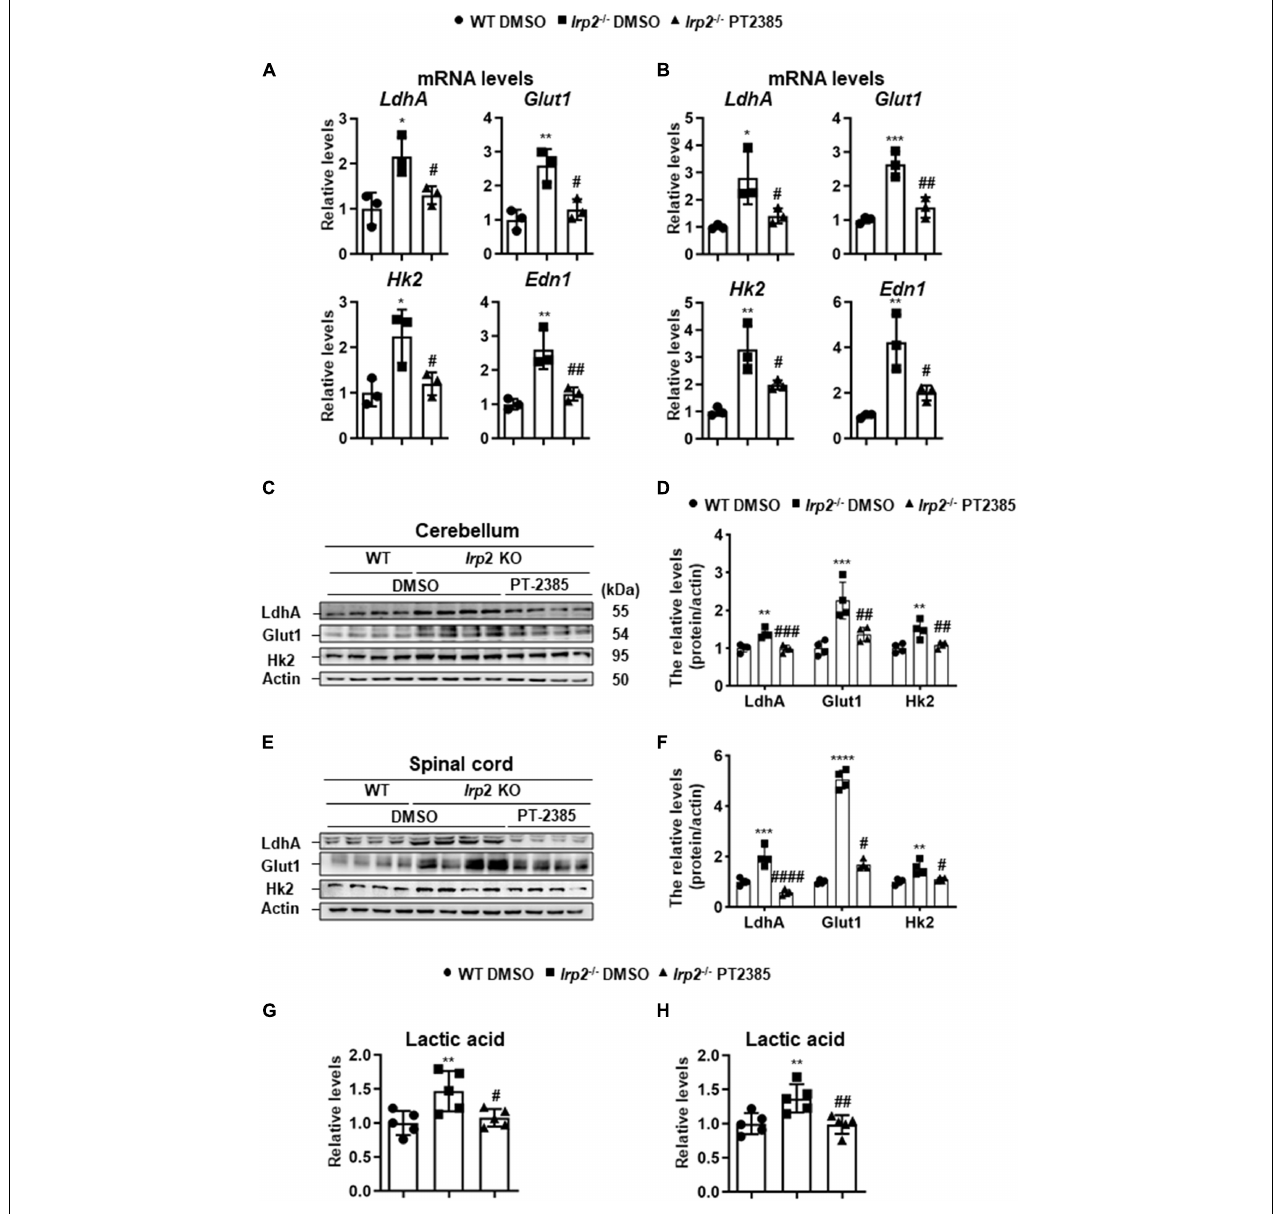
FIGURE 5 | Inhibition of Hif2 α by PT-2385 attenuates the enhanced glycolysis in the cerebellum and spinal cord of Irp2 − / − mice. (A,B) The mRNA levels of Hif-target genes LdhA , Glut1 , Hk2 , and Edn1 in the cerebellum (A) and spinal cord (B) , detected by qPCR. (C) Glycolytic pathway-related proteins (Glut1, Hk2, and LdhA) in the cerebellum detected by western blot analysis. Actin was used as an internal control. (D) Quantification of the band intensity for panel (C) . (E) The same proteins as in panel (C) in the spinal cord detected by western blot analysis. Actin was used as an internal control. (F) Quantification of the band intensity for panel (E) . (G,H) The lactic acid levels in the cerebellum (G) and spinal cord (H) . Values represented the mean ± SD, n = 3–5. The ANOVA was used for statistics to evaluate the group differences. In panels (A,B,D,F–H) , * P < 0.05, ** P < 0.01, *** P < 0.001, **** P < 0.0001, Irp2 − / − DMSO vs. WT DMSO; # P < 0.05, ## P < 0.01, ### P < 0.001, #### P < 0.0001, Irp2 − / − PT-2385 vs. Irp2 − / −